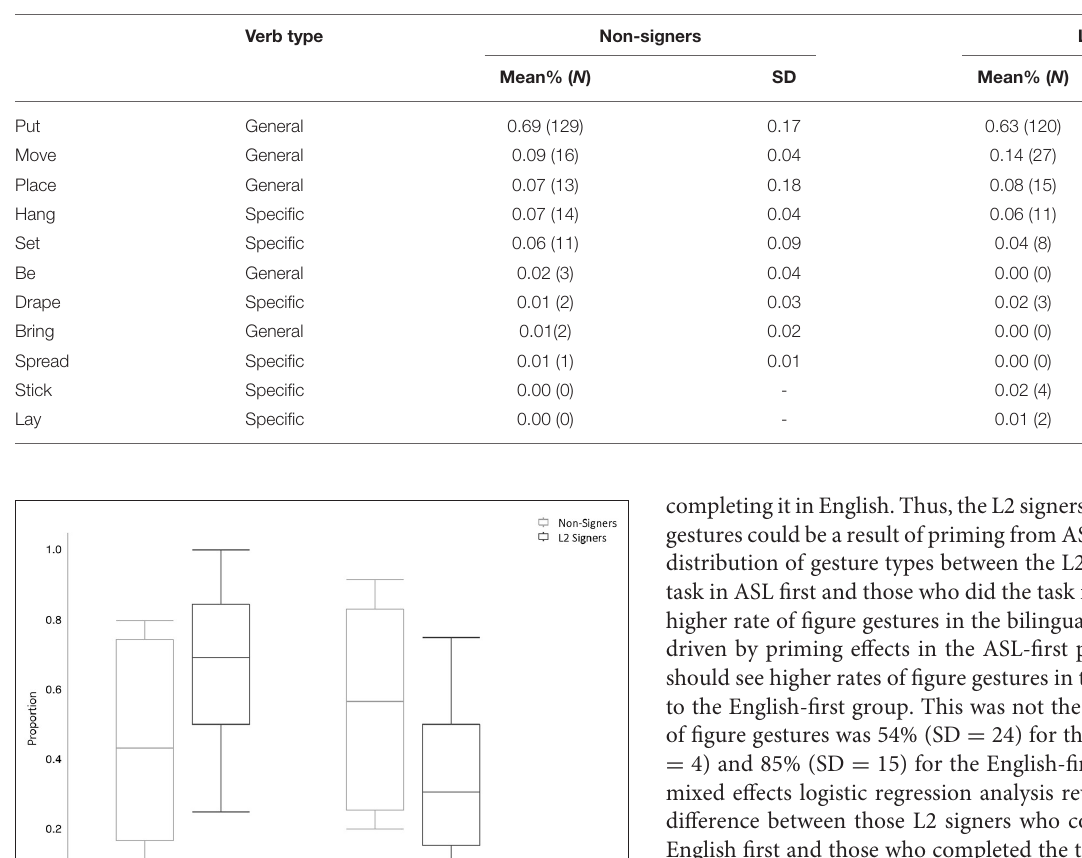
TABLE 5 | Verb frequencies in English by non-signers and L2 signers.